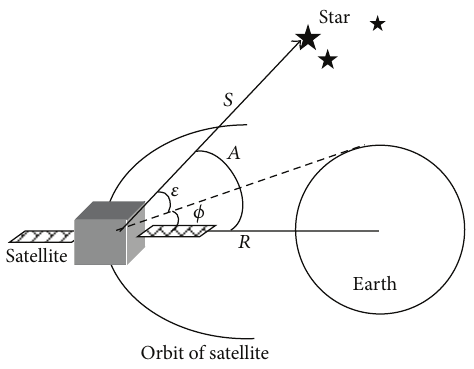
Figure 4: The autonomous theory with star light and ultraviolet earth.